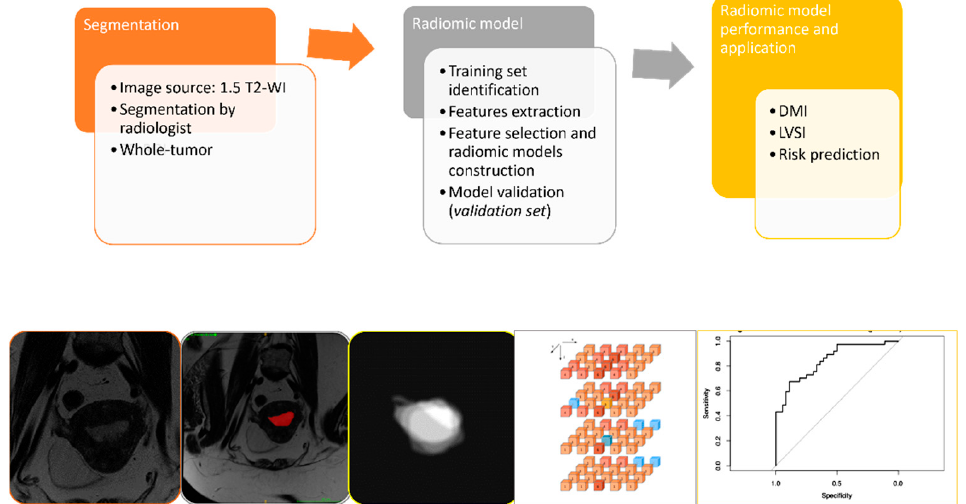
Figure 2. Outline of the project workflow consisting of whole-volume manual tumor segmentation on T2-weighed images, radiomic tumor feature extraction, and construction of radiomic signatures for prediction of selected outcomes in EC patients. The radiologist defined ROIs on T2-WI to extract intratumoral radiomic features; radiomic signatures were derived based on the whole-tumor masks (whole-tumor radiomics). Least absolute shrinkage and selection operator (LASSO) was applied for prediction modeling.